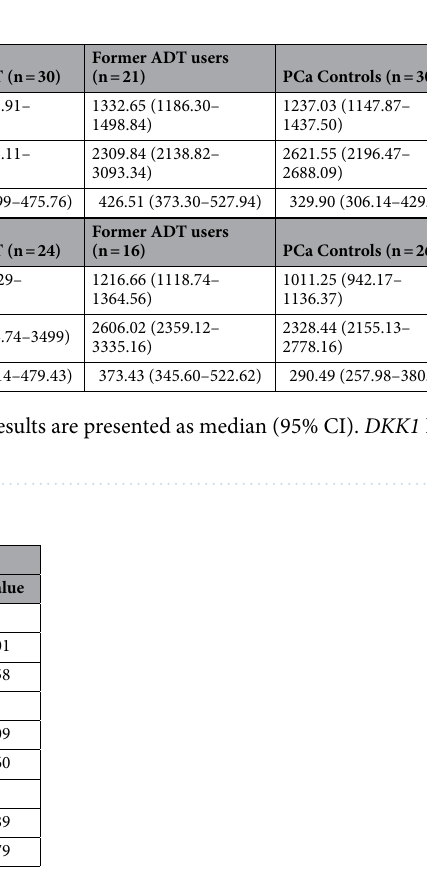
Table 3. Correlation of serum sclerostin, DKK-1, OPG, age and BMI. DKK1 Dickkopf-1, OPG osteoprotegerin.